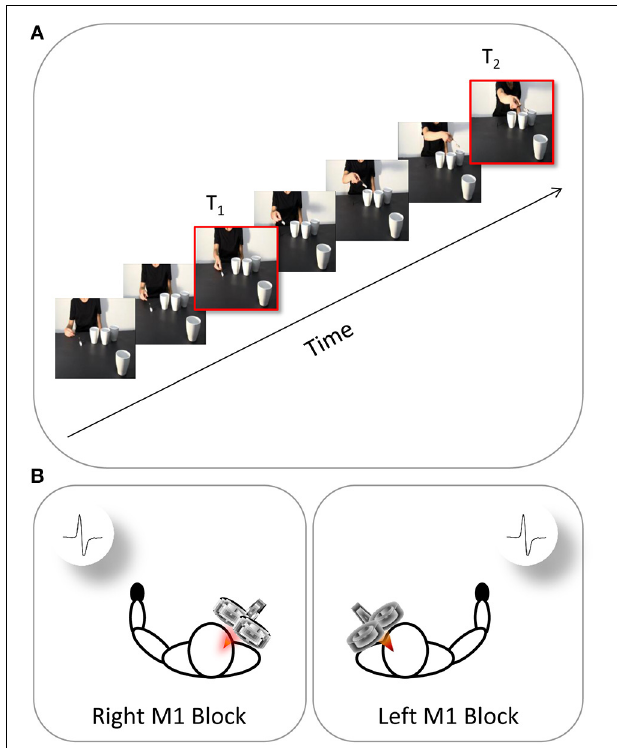
FIGURE 2 | Time and location of TMS stimulation. The continuous oblique line represents the duration of video-clip presentation. (A) During each video presentation (e.g., a social action performed by the right-handed actor), TMS was delivered at two different time points (T 1 , T 2 ). (B) EMG recordings were collected at these time points from both the participant’s left hand (right M1 block) and right hand (left M1